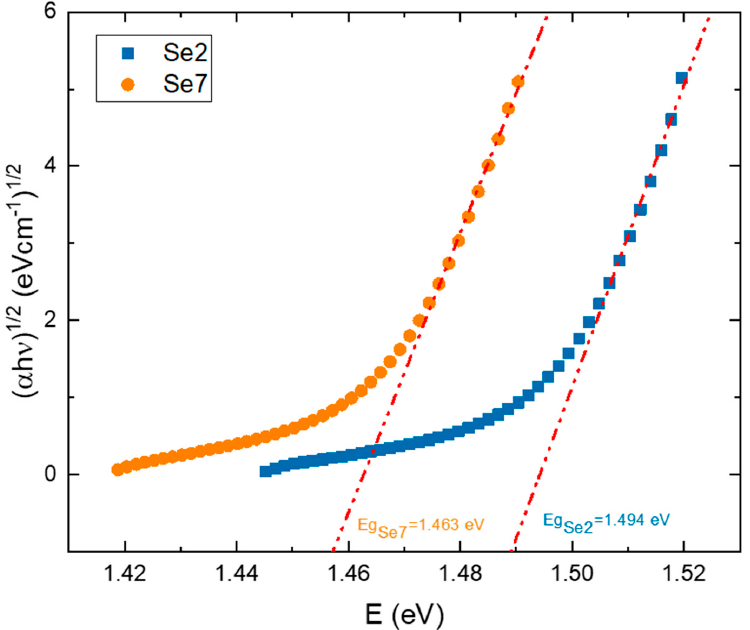
Figure 7. ( α h ν ) 1/2 versus energy of the Se2 and Se7 samples at room-temperature measurement. The intercept with the energy axis corresponds to the optical bandgap of CZTS.